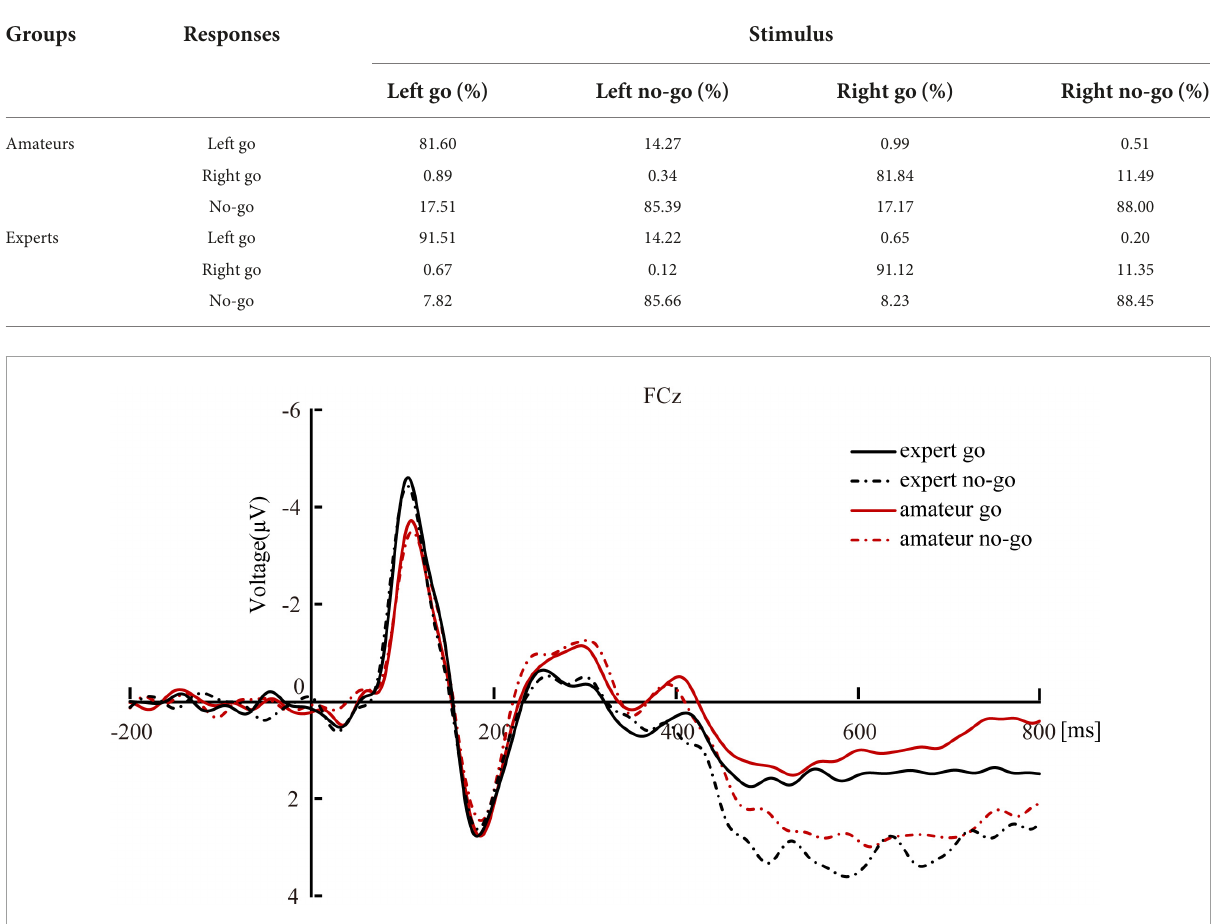
TABLE 2 Percentage of different stimulus in each type of response.